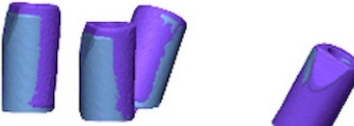
Figure 4. STL file to be measured superimposed over the reference STL file using best fit algorithm. Congruence between the two superimposed scans was expressed quantitatively by measuring the 3D deviations (Figure 5) and angular deviations of each ISB. 3D comparison option was used to determine 3D distortions in mm. Then, means ± standard deviations (SD) of these distortions were calculated after obtaining the Root Mean Square (RMS) of each ISB that was unitless [49]. For the angular discrepancies, the geometrical deviation option in the software was implied after defining the geometrical shape to be cylindrical in this case due to the topography of the ISBs. The distortion level between the control and measured scans was calculated in degrees. Finally, for a better empirical evaluation of the 3D deviations between the files and interpretation of the directivity of the